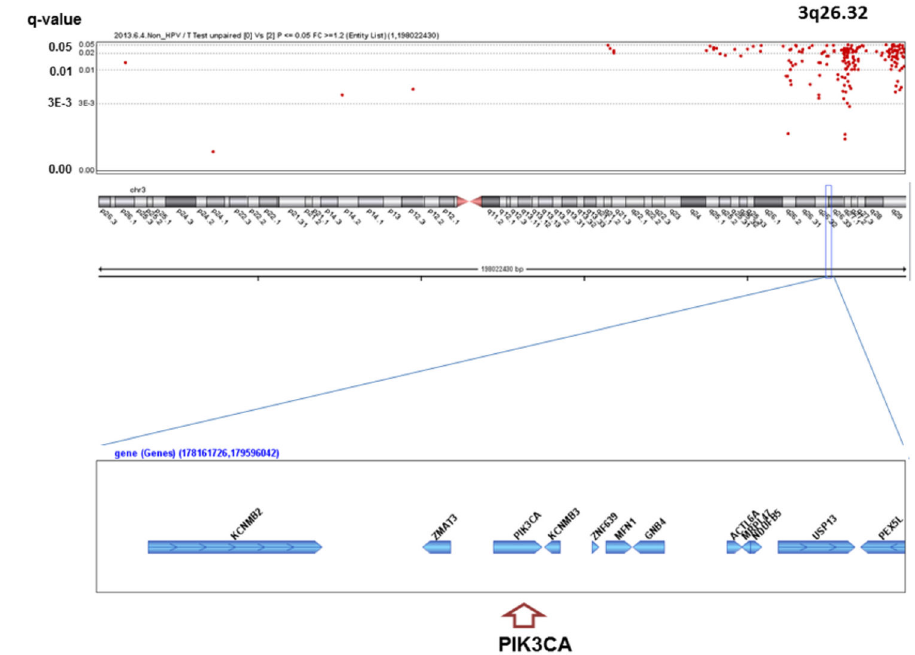
Figure 4. Significant SCNAs at 3q26.32 associated with heavy alcohol consumption.